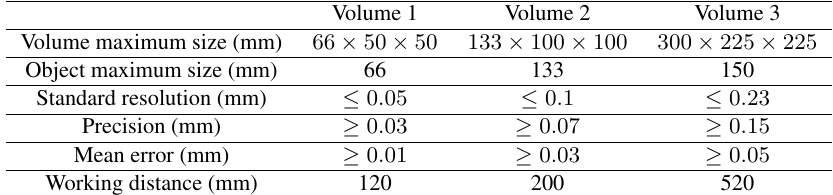
Figure 1: From left to right, the replicas of the tablet from Damascus, the tablet from Ebla, the clay ball and the tablet from Ugarit